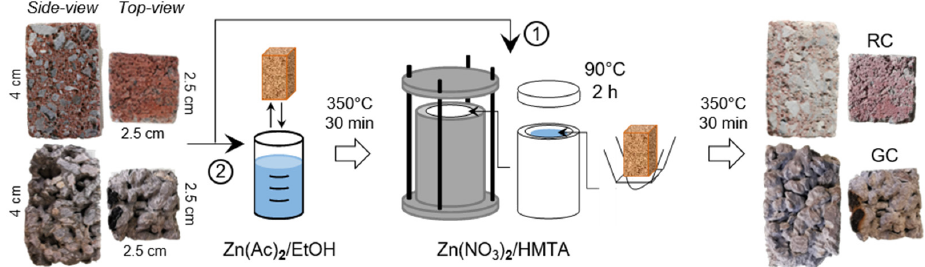
Figure 1. Schematic routes of concrete functionalization by classical hydrothermal growth in two steps (2) and seedless hydrothermal growth (1), and optical photographs of the grey concrete (GC) and red concrete (RC) blocks before and after the ZnO NS growth.